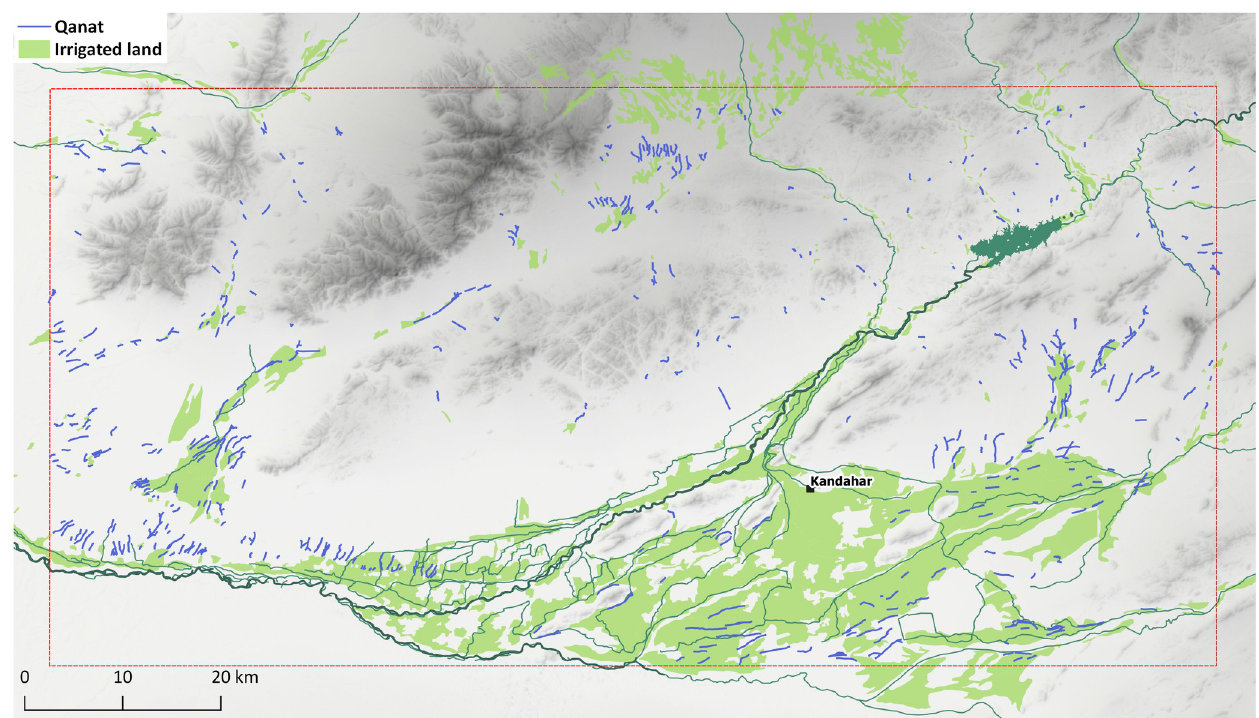
Fig 10. Map showing the distribution of qanats . DEM based on Shuttle Radar Topography Mission (SRTM) 1 Arc-Second Global courtesy of the U.S. Geological Survey (doi:10.5066/F7PR7TFT) (https://earthexplorer.usgs.gov). The map was created by the authors in QGIS.